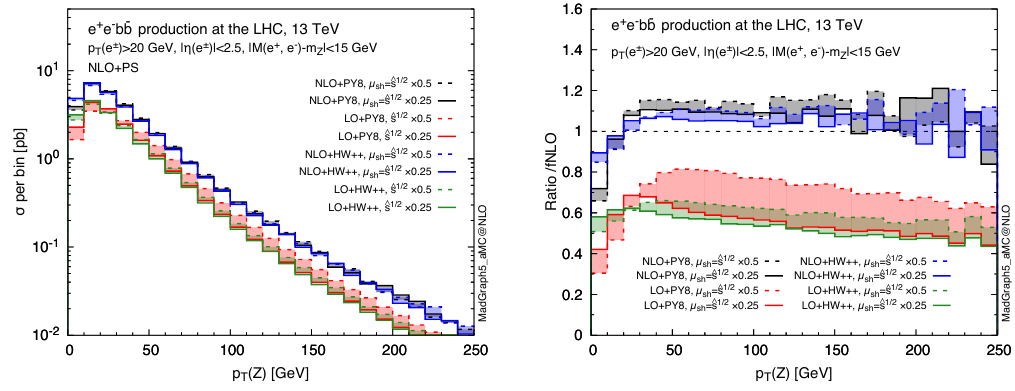
Figure 8 . p ‘ + ‘ (cid:0) distribution in the 4FS inclusive over the b quarks contribution. Comparison of ? the results obtained with LO+PS and NLO+PS accuracy with Py8 and Hw++ , for a given choice of the matching